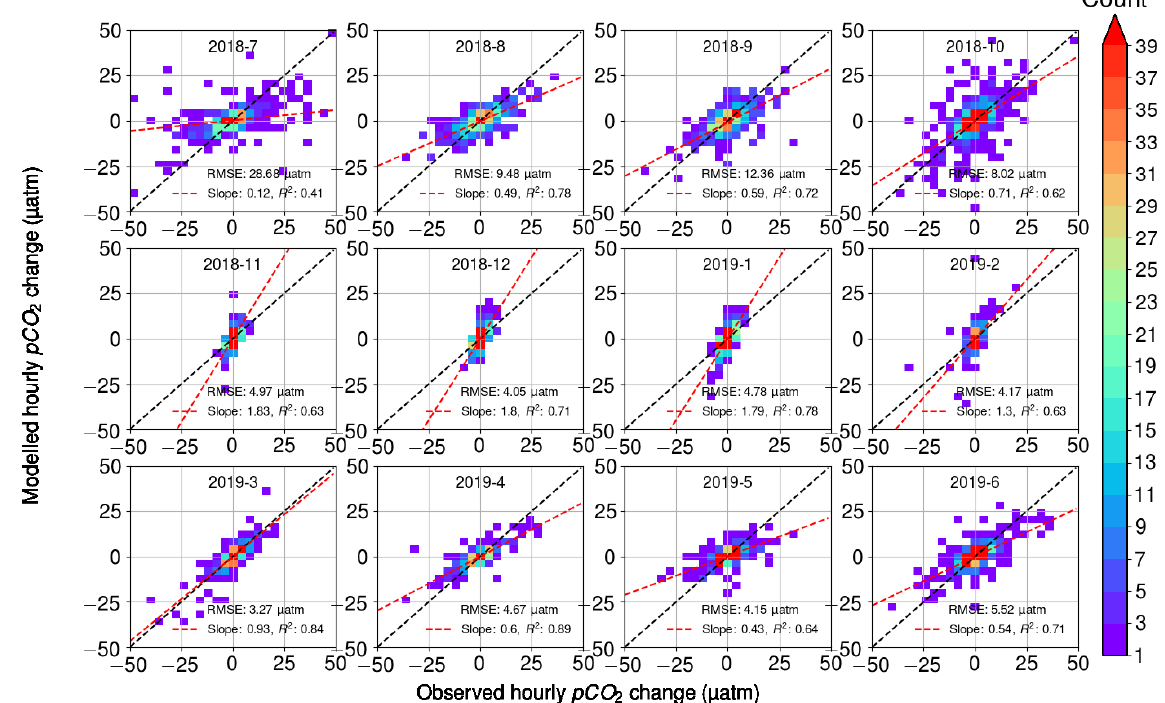
Figure 9. Modeled hourly p CO 2 changes as a function of observed p CO 2 changes. Color indicates the number of observations within bins of 2µatm width. For each month, the RMSE between the model and the observations is given, as well as the slope of the best fit (red line) with its correlation coefficient. The black line is the identity (1 : 1)